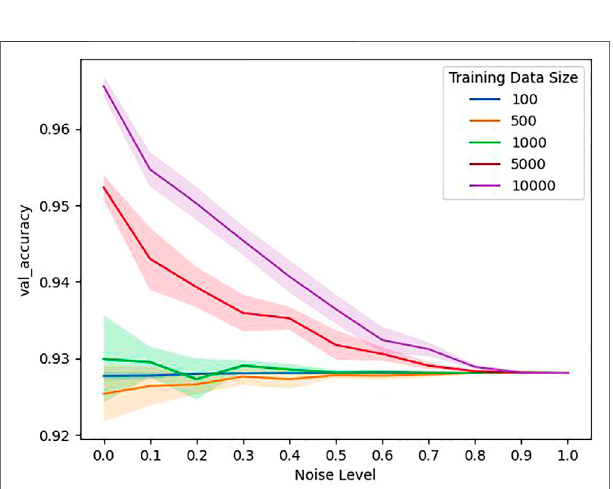
FIGURE 2 | Accuracy on a clean validation set for different noise levels and sizes of the training set. Transparent area gives the standard deviation of 10 repetitions of the training procedure.